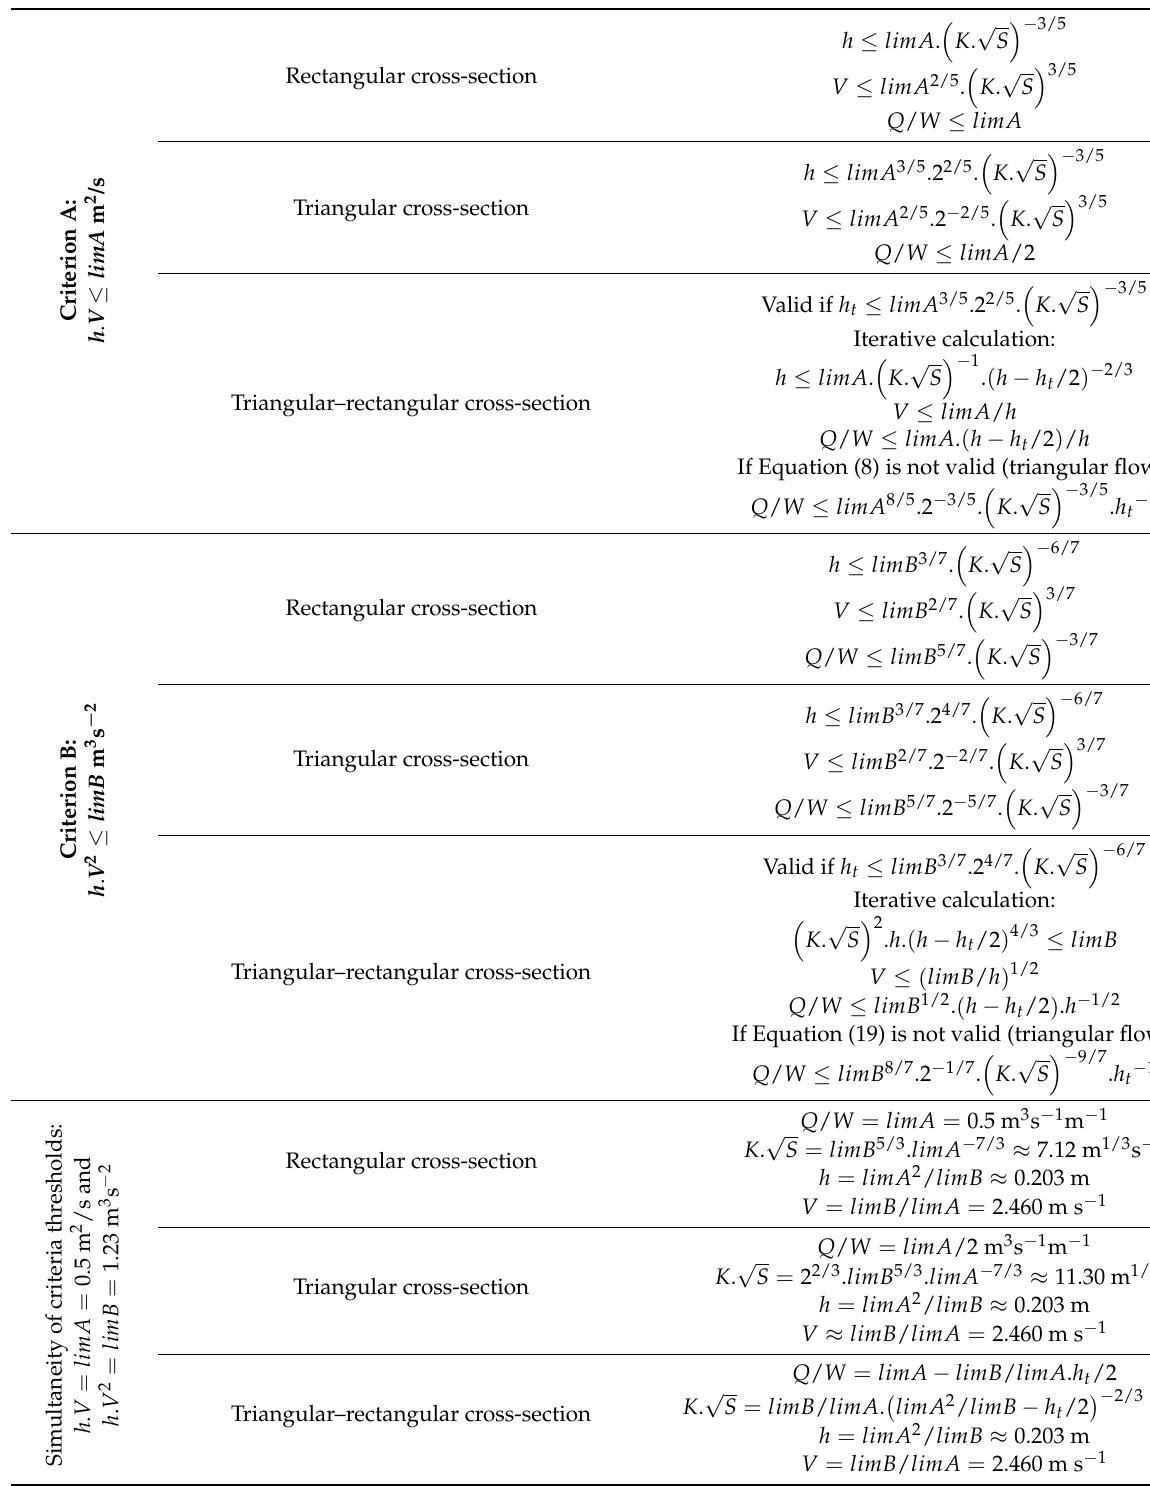
Table 1. Equations (adapted from